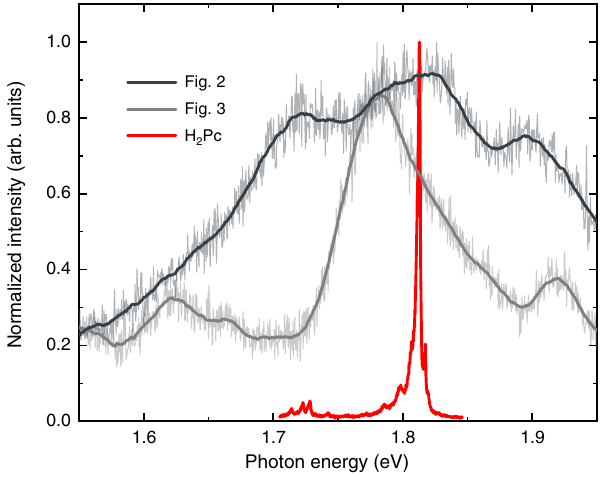
FIG. 13. Plasmonic spectra of the tips used to perform measurements shown in Figs. 2 and 3. The spectrum of the molecule is shown as a reference. Parameters for all spectra are as follows: V ¼ − 2 . 5 V, I ¼ 100